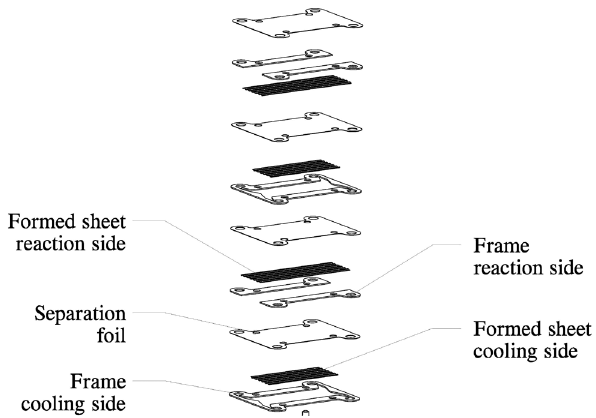
Figure 3 Basic design of a stacked plate microreactor (exploded view) comprising plates microstructured by using roll